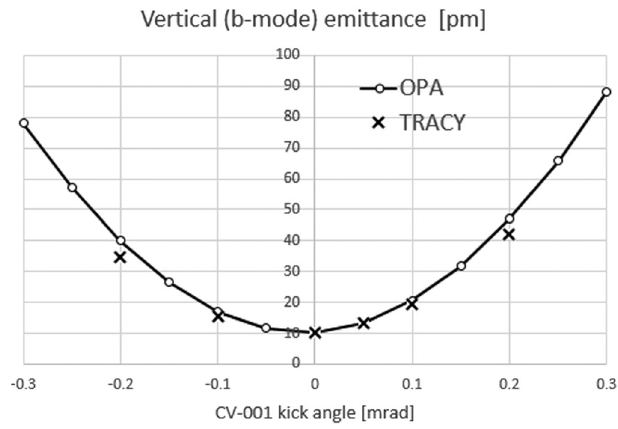
FIG. 5. Comparison of OPA - and TRACY calculations of vertical emittance due to orbit distortion, if one vertical corrector is 7 . 6 excited (located at β y ¼